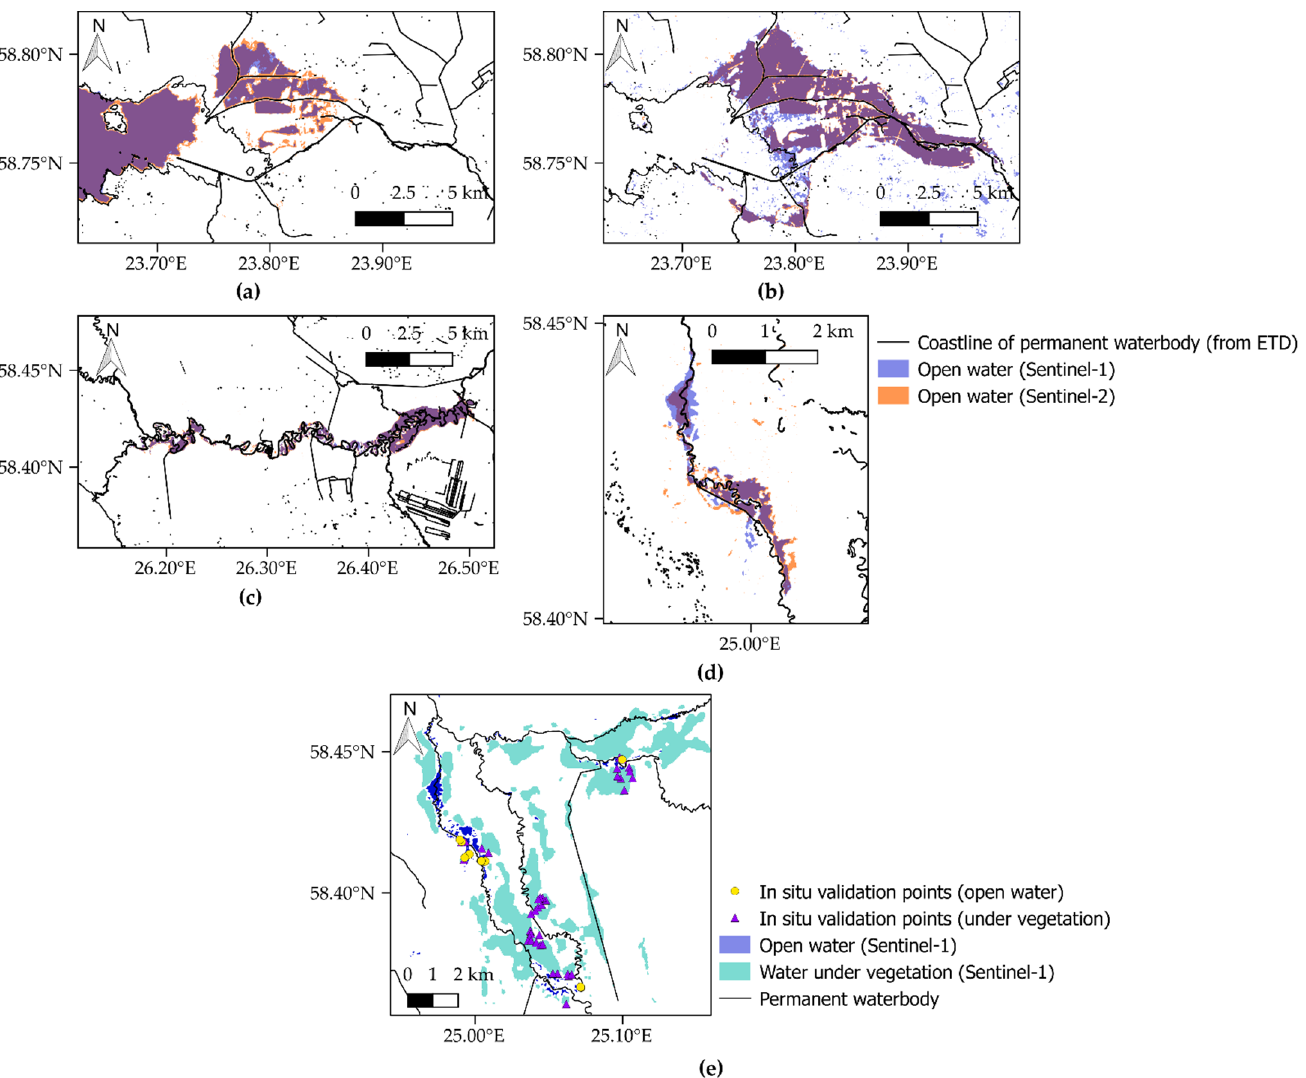
Figure 4. Validation results. ( a ) Open water mapped from S1 EW HV data vs. S2 MNDWI (4 April 2019), ( b ) Open water mapped from S1 IW VH data vs. S2 MNDWI (23 March 2019), ( c ) Open water mapped from S1 IW VH data vs. S2 MNDWI (5 April 2019), ( d ) Open water mapped from S1 IW VH data vs. S2 MNDWI (16 November 2017) and ( e ) Comparison of in situ validation points (22 March 2019) with open water mapped from S1 VH data (24 March 2019) and water mapped under vegetation from S1 EW HH data (23 March 2019).